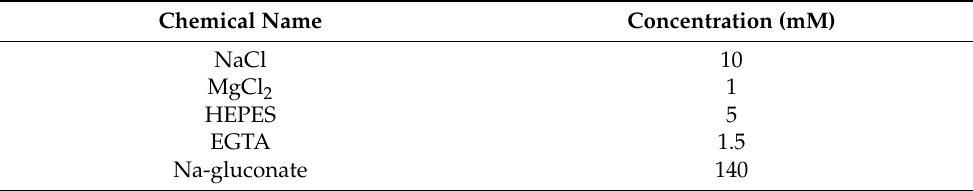
Table 4. E2 Extracellular Solution (Na-Glu)